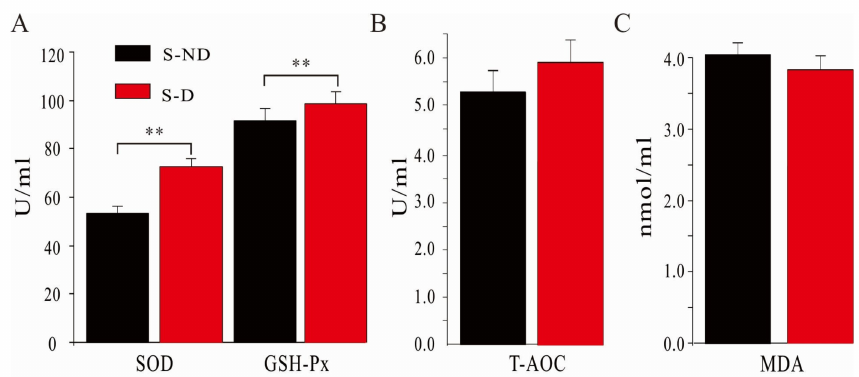
Figure 3. E ff ects of dihydropyridine (DHP) on serum antioxidative index. Twenty heat-sensitive dairy cows were divided into control (S-ND) group and experimental (S-D) group. The control group (S-ND) was fed with the standard diet. The experimental group (S-D) was fed with the standard diet containing 3 g / day / cow DHP. ( A ) E ff ects of DHP on serum SOD and GSH-Px concentration; ( B ) e ff ects of DHP on serum T-AOC level; ( C ) e ff ects of DHP on serum MDA content. **: p < 0.01.